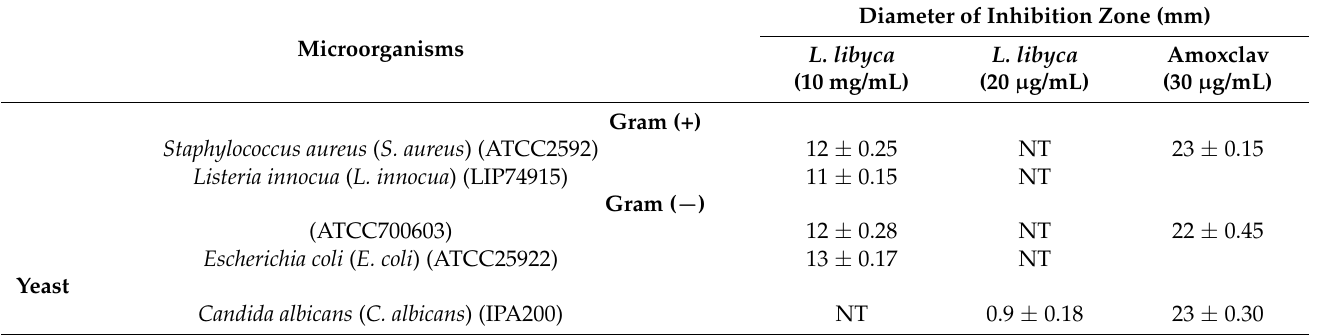
Table 6. Diameters of inhibition zones of bacterial strains treated with the methanol extract of L. libyca (n = 3).